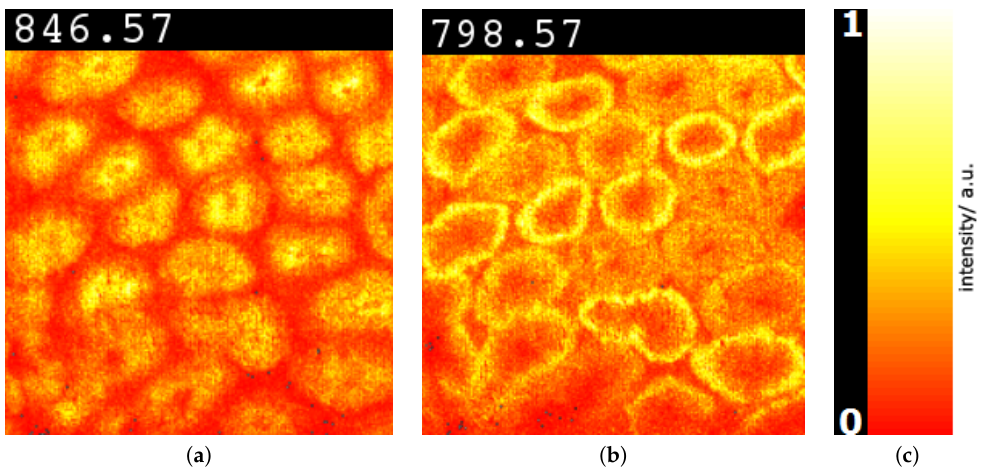
Figure 19. Image-space visualization of rat testis data set [9] for peaks with m / z -ratios 846.57 ( a ) and 798.57 ( b ) selected in Figure 18. Multi-hue luminance color map ( c ) exhibits spatial intensity